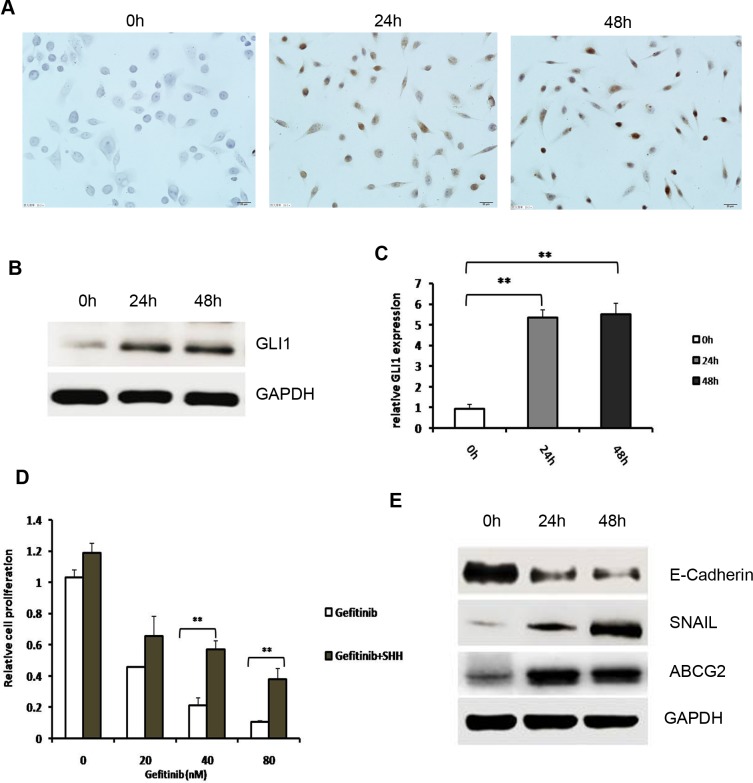
Upregulation of Hh signaling pathway activity by exposure to SHH lead to gefitinib tolerance accompanied by EMT induction and ABCG2 upregulation in EGFR-TKI-sensitive NSCLC cells.(A) Immunocytochemical analysis of GLI1 in PC9 cells after N-Shh (0.5 μg/mL) treatment for 0, 24, and 48h. GLI1 expression in PC9 cells was negative without exposure to N-Shh. GLI1 was expressed in the nuclei after N-Shh treatment for 24 and 48 h. (B) Western blot analysis of GLI1 in PC9 cells after N-Shh (0.5 μg/mL) treatment for 0, 24, and 48h. (C) Q-PCR analysis of GLI1 mRNA relative expression in PC9 cells after N-Shh (0.5 μg/mL) treatment for 0, 24, and 48h; GLI1 expression was obviously elevated after exposure to N-Shh for 24 h and 48 h; ** (P<0.01). (D) Proliferation of PC9 cells was assessed by MTT assay after treatment with the indicated concentrations of gefitinib with or without pre-exposure to extrinsic N-Shh (0.5 μg/mL) for 24h; compared with the gefitinib single-agent group, exposure to extrinsic N-Shh significantly increased gefitinib tolerance in PC9 cells ** (P<0.01). (E) Western blot analysis of E-Cadherin, Snail and ABCG2 in PC9 cells after N-Shh (0.5 μg/mL) treatment for 0, 24, and 48h.